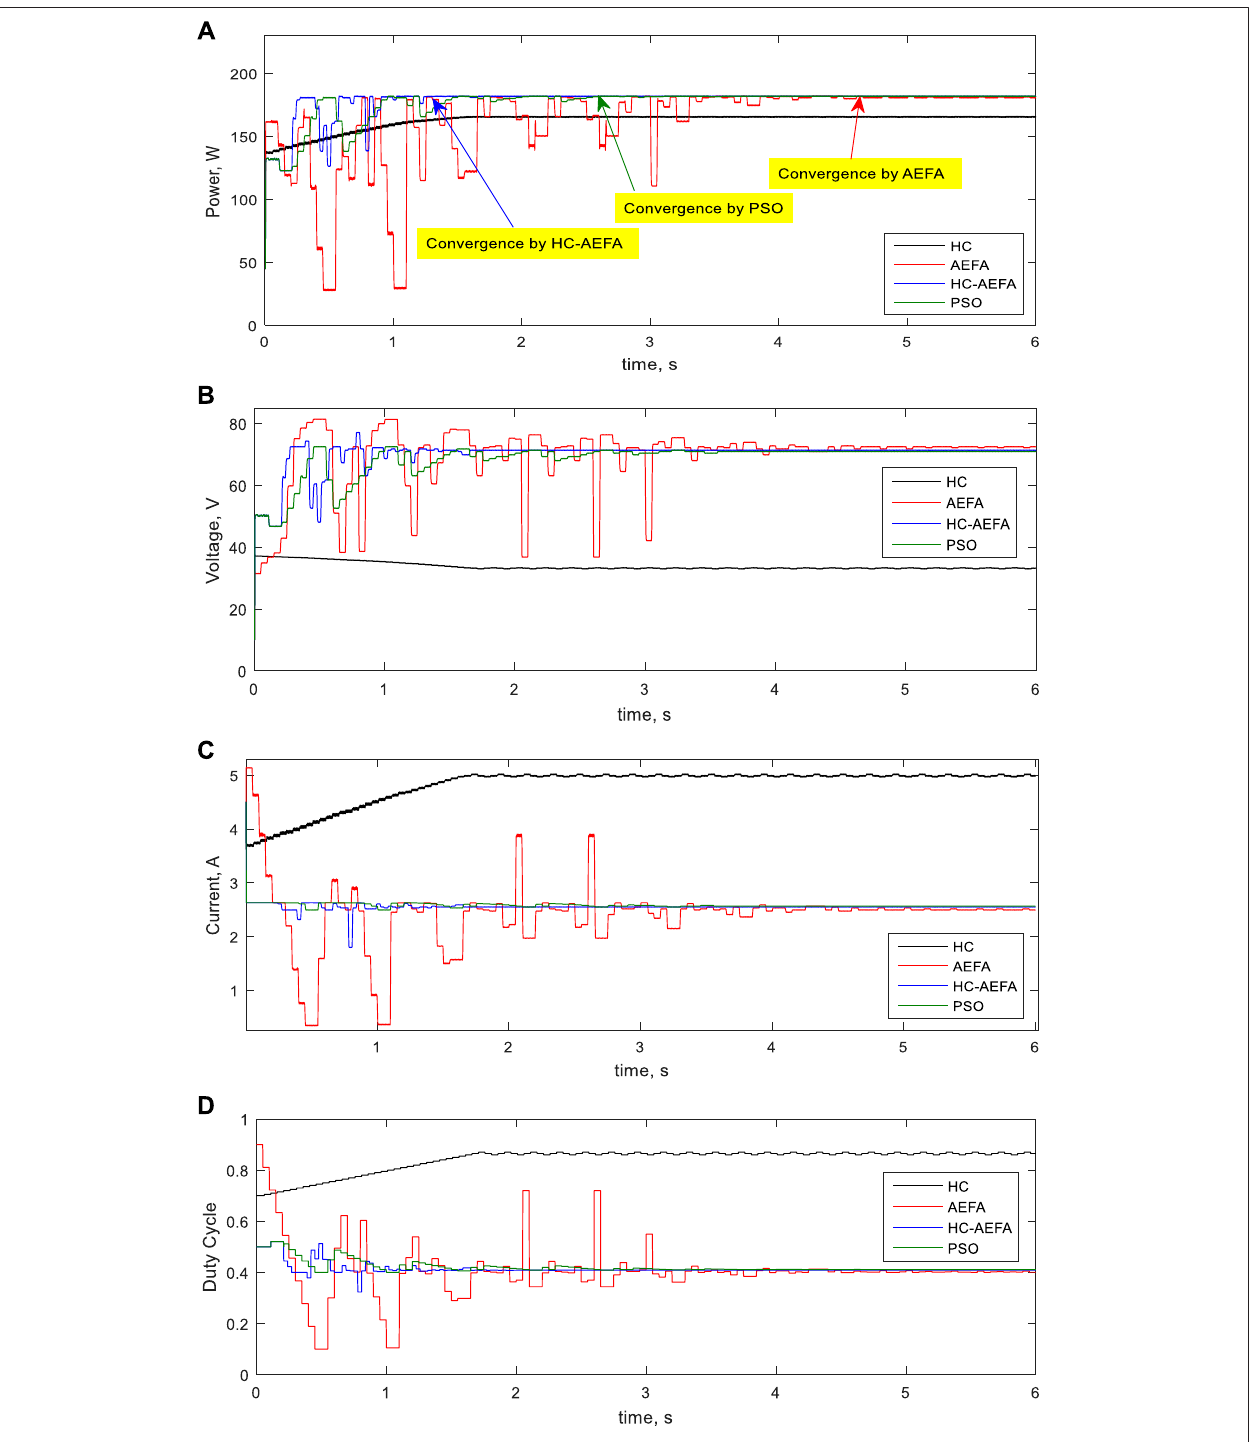
FIGURE7| SimulationwaveformsatthesecondpatternobtainedusingtheHC-AEFA, HC,AEFA,andPSOmethods; (A) PVoutputpower, (B) PVoutputvoltage, (C) PV output current, and (D) converter duty-cycle curves.